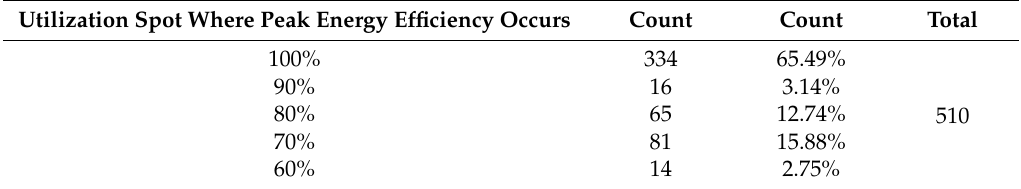
Table 2. Peak energy efficiency occurrence by utilization spot.